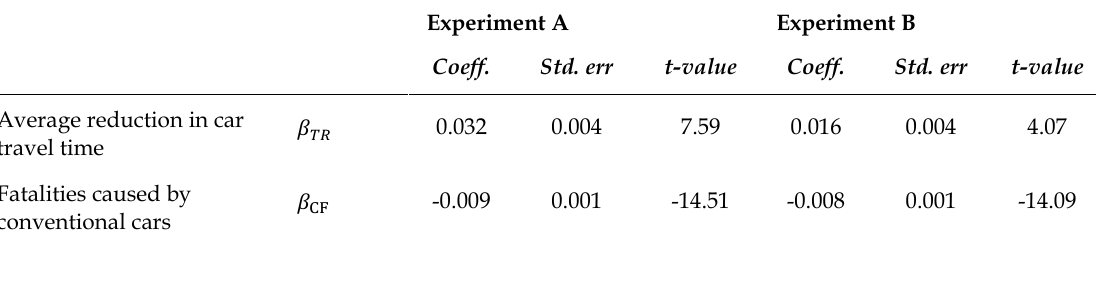
Estimation results of the base model (Equation